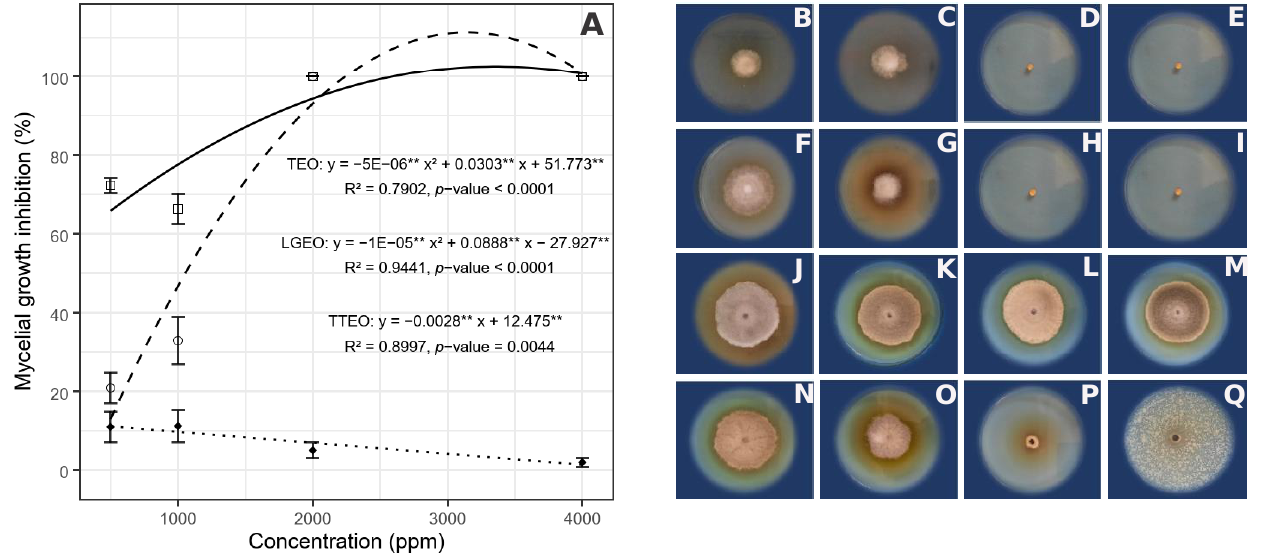
Figure 2. ( A ) Regression analysis between treatment concentrations and mycelial growth inhibition of Alternaria linariae . Treatments: thyme essential oil (TEO ‒‒‒□‒‒‒), lemongrass essential oil (LGEO ---- ○ ---) and tea tree essential oil (TTEO …..♦….. ). Data represent the means of values from two independent experiments ( n = 10). ** statistical significance of the coefficients of the regression models by the F test ( p ≤ 0.01). R 2 , coefficient of determination. ( B – E ) Photographs of the mycelial growth of A. linariae on PDA + TEO culture medium exposed to concentrations of 500, 1000, 2000 and 4000 ppm; ( F – I ) PDA + LGEO at concentrations of 500, 1000, 2000 and 4000 ppm; ( J – M ) PDA + TTEO at concentrations of 500, 1000, 2000 and 4000 ppm, respectively; ( N ) PDA + distilled water; ( O ) PDA + Azoxystrobin; ( P ) PDA + tebuconazole; and ( Q ) PDA + Bacillus amyloliquefaciens MBI600. The treatment with TEO was highly effective at controlling conidial germination of A. linariae , with extremely low germination percentages, fluctuating between 7.78% and 0.89% at concentrations of 500 to 4000 ppm, respectively. High levels of control were also observed in the treatment with LGEO, with germination percentages of only 15.30% to 1.11% at concentrations of 500 to 4000 ppm, respectively (Figure 3). Both EOs, at different concentrations, were statistically superior ( p ≤ 0.05) to the control treatments BCA BMI600, tebuconazole, azoxystrobin and distilled water. On the other hand, high percentages ( ≥ 96%) of conidial germination were observed in the TTEO treatment, which indicated a reduced ability to inhibit the germination of A. linariae conidia.